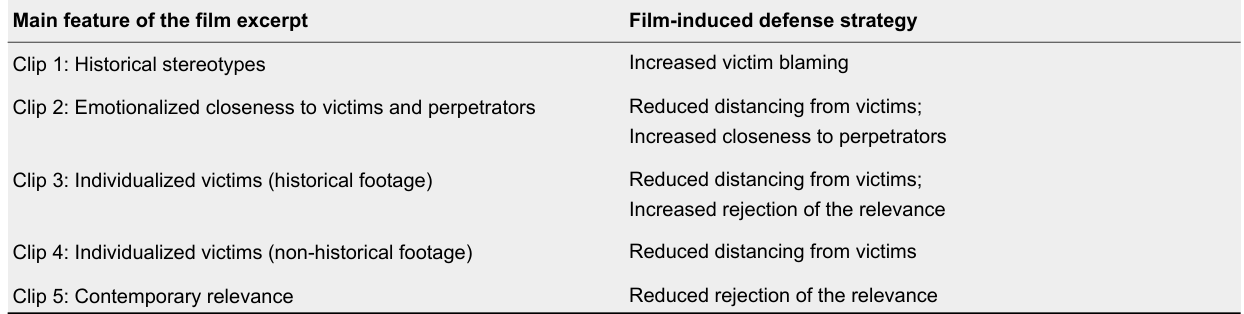
Film-induced defense strategyMain feature of the film